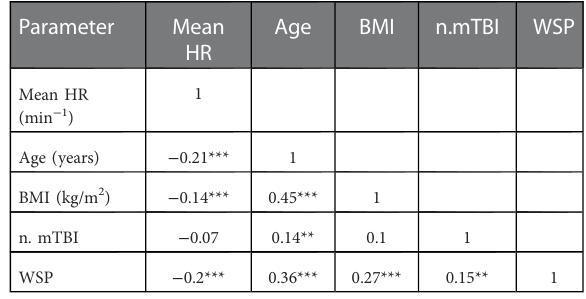
TABLE 1 Association between variables selected as potential independent predictors of standard HRV parameters.